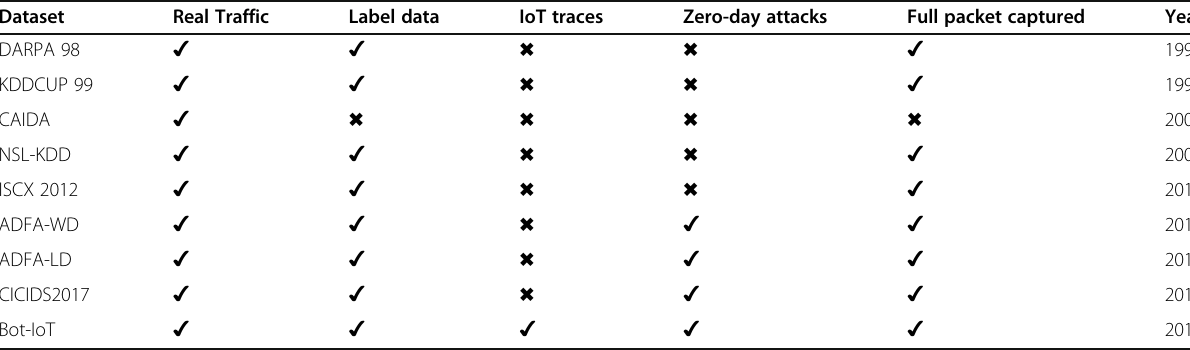
Table 10 The compassion of datasets ( ✔ = True, ✖ = False)